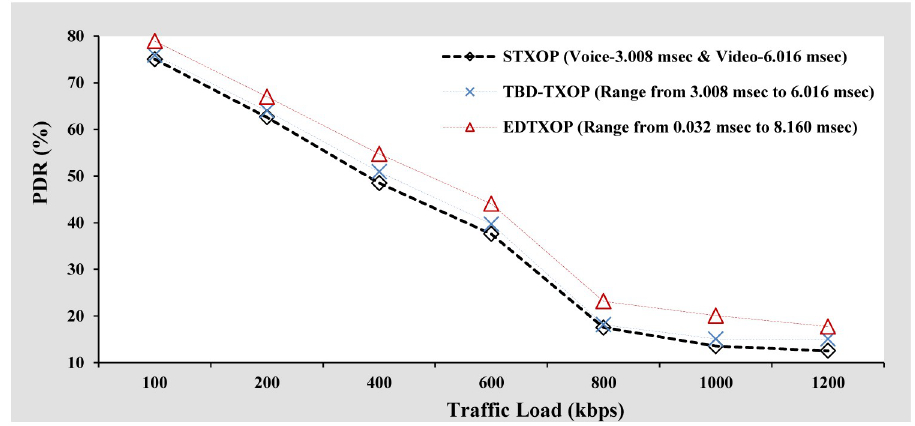
Fig 5. PDR analysis based on increasing packet size.